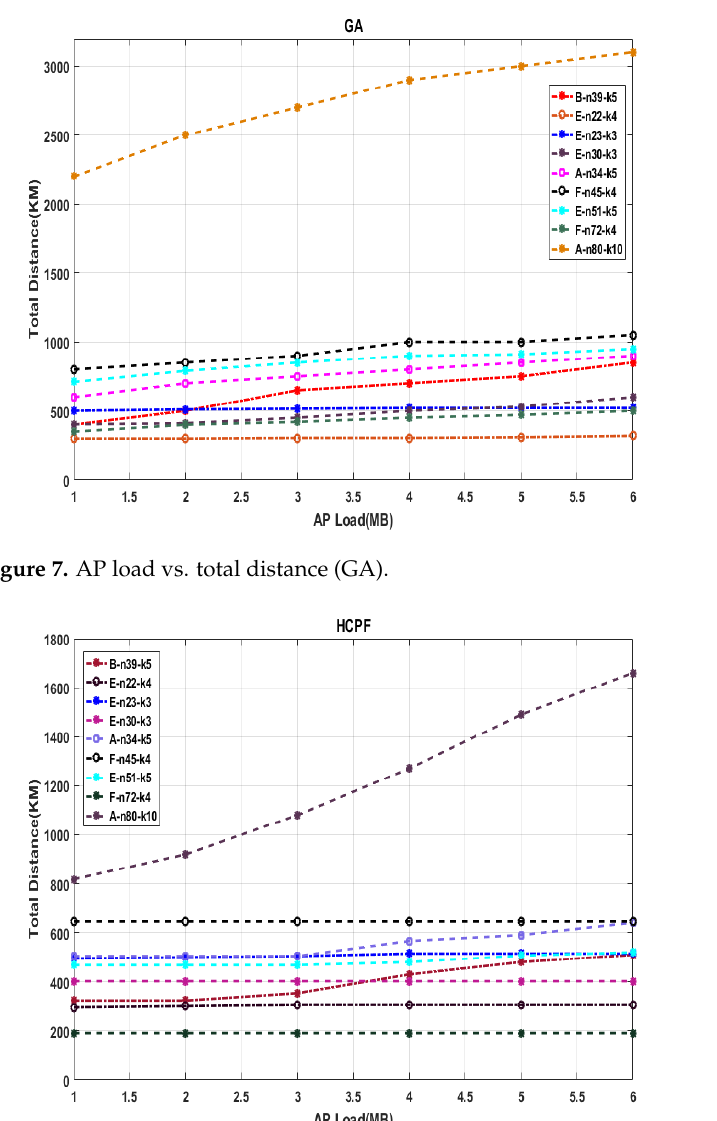
Figure 8. AP load vs. total distance (HCPF).